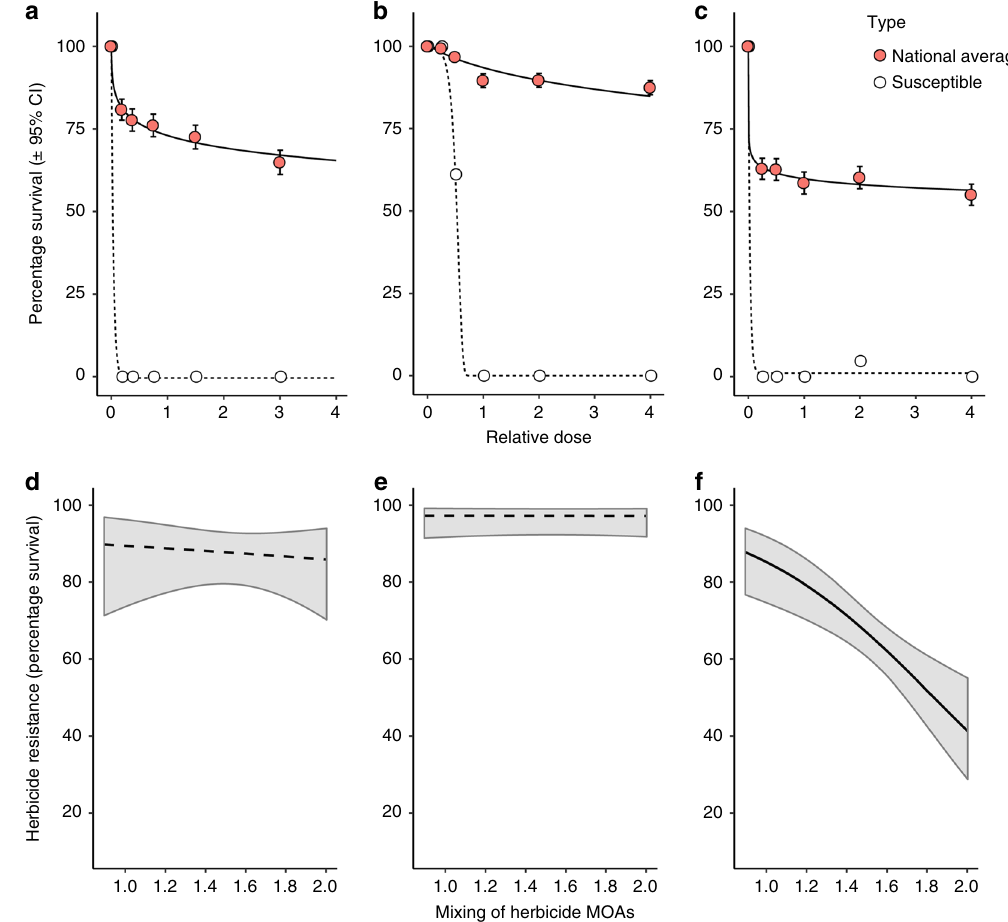
Fig. 1 Assessment of phenotypic herbicide resistance in UK A. myosuroides populations. The fi tted relationships between herbicide dose and plant survival are shown for ( a ) the ‘ SU ’ herbicide mesosulfuron, ( b ) the ‘ Fop ’ fenoxaprop and ( c ) the ‘ Dim ’ cycloxydim. Red fi lled circles and solid lines represent the mean response across all 132 fi eld-collected populations, providing an estimate of the national level of resistance to these herbicides. For comparison, dotted lines and un fi lled circles show the response in a herbicide susceptible standard population. Error bars show the 95% con fi dence interval about the mean. d – f show the predicted relationship between the historical intensity of herbicide mixtures applied to fi eld-collected populations and population-level resistance (percentage survival following glasshouse resistance assays) to the SU, Fop and Dim herbicides, respectively. Fitted lines show the mean predicted relationship following mixed model analysis (see Supplementary Table 1), with shaded regions representing the 95% con fi dence interval. A solid black line is used for a signi fi cant relationship ( f ) ( p ≤ 0.001), while dashed lines are used where the relationship was non-signi fi cant ( d , e ). Source data for panels ( a – c ) are provided as a Source Data fi le. Experiments were conducted once for each herbicide, screening 108 plants per population over six